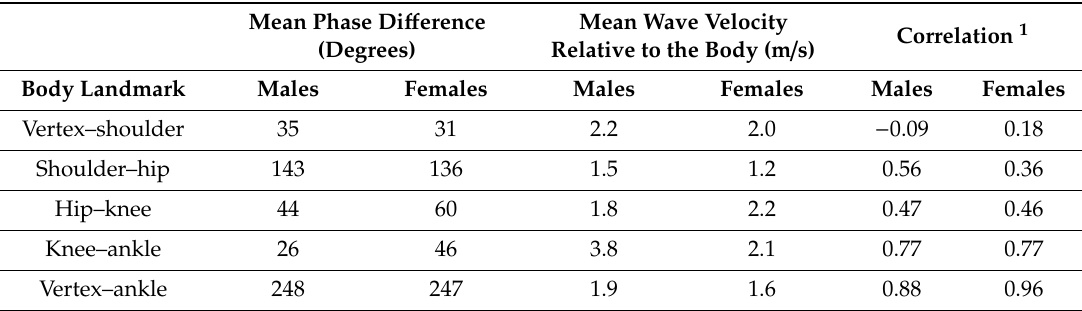
Table 1. Mean phase di ff erences and velocities of the two-beat wave travel between body landmarks in the Sanders et al. [11] study. Mean Phase Di ff erence Mean Wave Velocity Correlation 1 (Degrees) Relative to the Body (m / s) Body Landmark Males Females Males Females Males Females